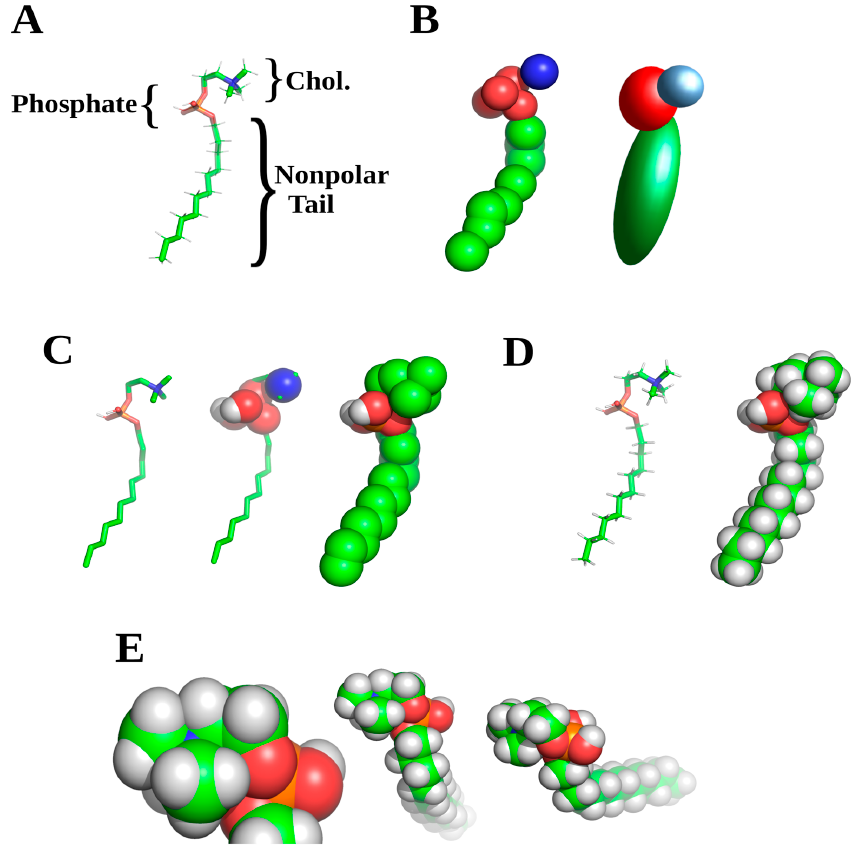
Figure 2. Force Field comparisons. ( A ) Di-phosphatidyl Choline (DPC) is shown with all atoms represented by sticks, Carbon (green), Oxygen (red), Nitrogen (blue), Phosphate (orange), and Hydrogen (white) ( B ) CG model, the atom radius space filling model, left, is represented by averaged space filling representations of charge. Neutral lipid tail (green) and head groups (blue, red) generate 3 space and charge models for the entire molecule. ( C ) Partial atom model. Left, only polar hydrogens are represented alone, while non-polar hydrogens are merged with the respective carbon, increasing point charge radius. Center, space filling model charge portions including hydrogens. Right, the final individual space filling and charge representations with merged hydrogen. ( D ) All atom model, left—stick representation, right—a final space filling model with hydrogens, inclusive of weak partial charges. ( E ) A close ‐ up of all atom models with surface charges. Hybrid models burry these with larger radius composites. Small sub ‐ angstrom charges shown as accessible surfaces, exposed colored areas of Nitrogen (blue) and Phosphate (orange), highlighted as green dots on the surface of the nitrogen in ( C ), middle, are particularly important for specific lipid interactions involving electron transfer, or lipids fixed to proteins or other molecules for extended periods.